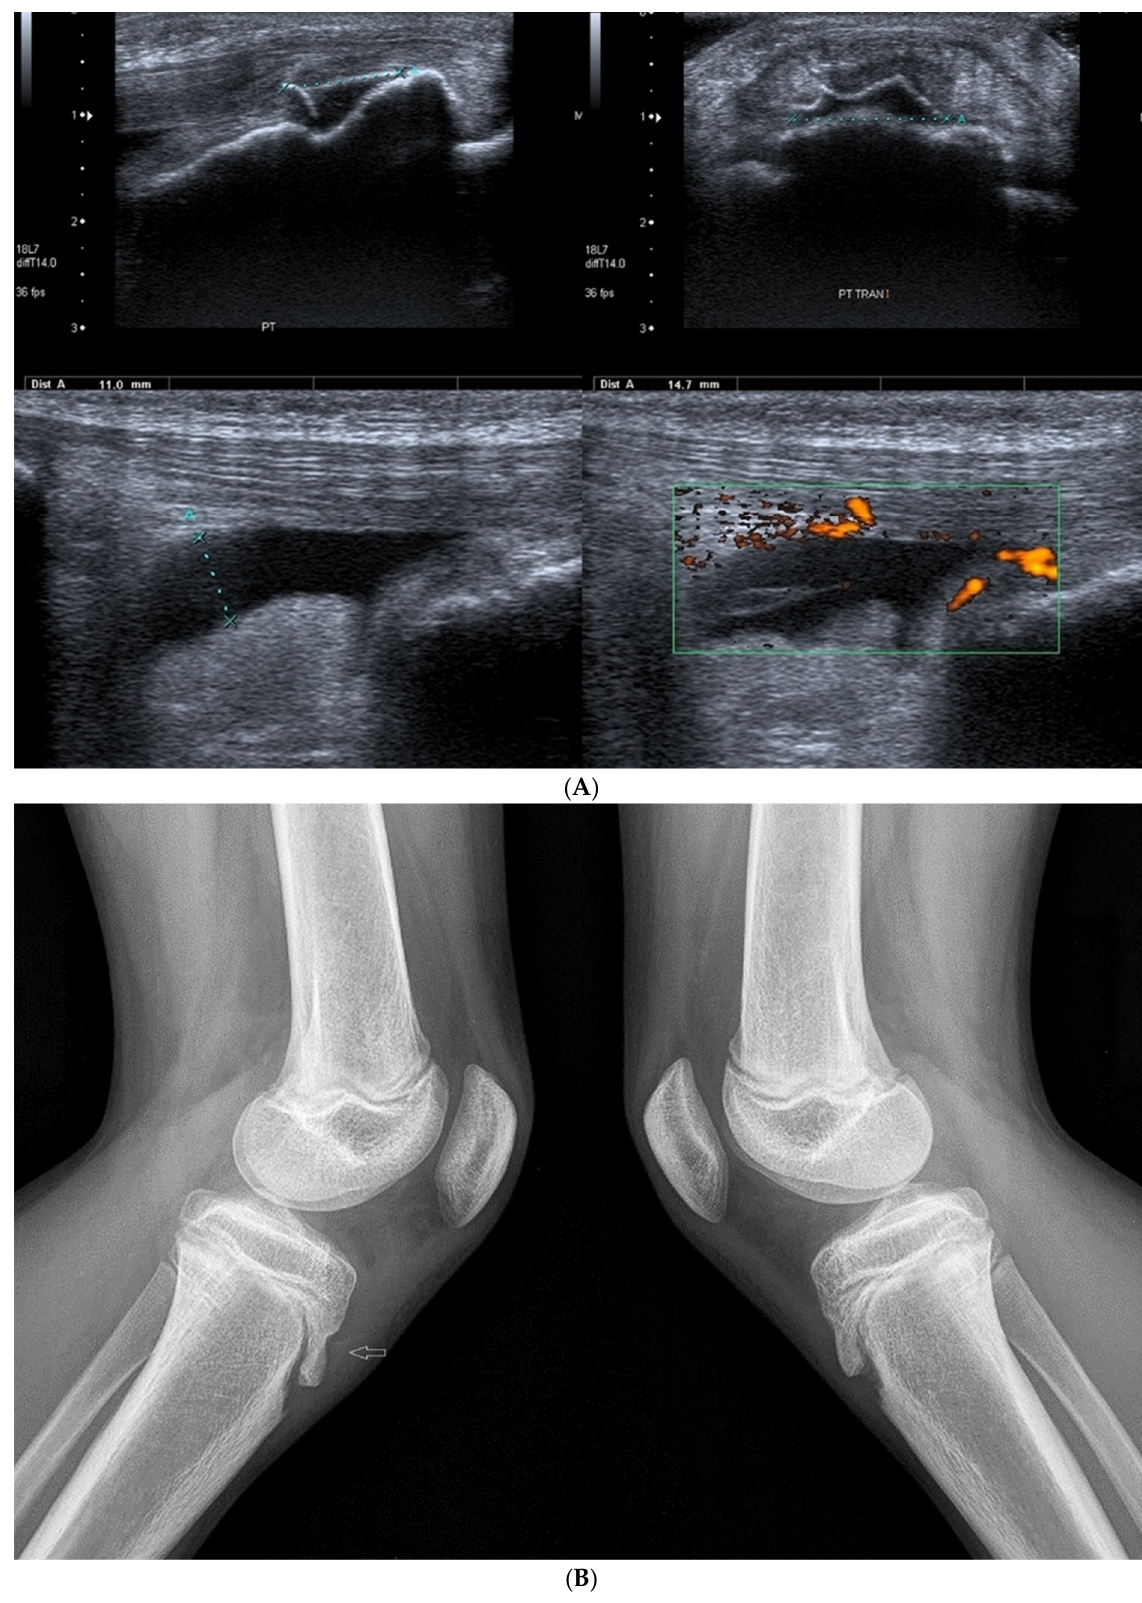
Figure 9. ( A ) The case of a 13-year-old girl in whom the symptoms of Osgood–Schlatter disease were clearly related to a sport injury (avulsion of the bony fragment from the tibial tuberosity). At the top, there are scans, longitudinal on the left and transverse on the right, with a marked thin layer of bone detached from the surface of the tibial tuberosity. At the bottom, two scans in the longitudinal